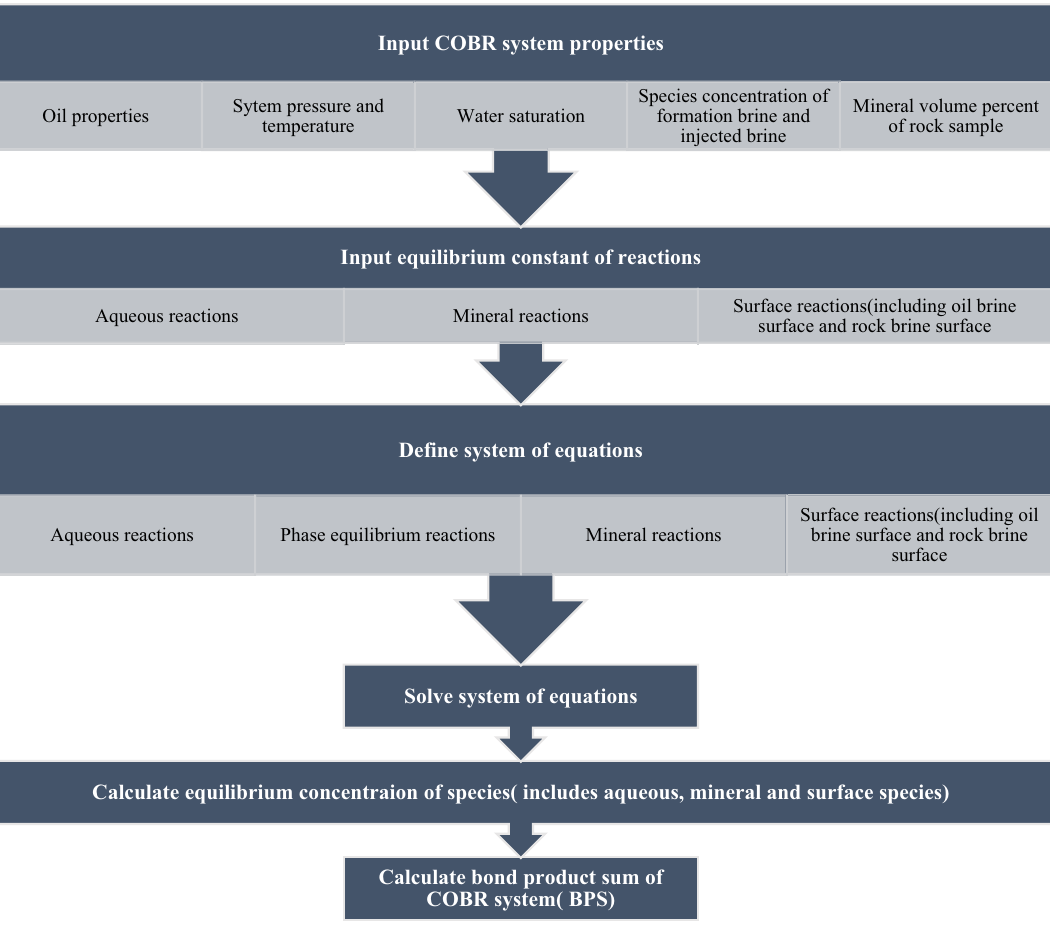
Figure 2. Flowchart of the developed model for wettability determination using BPS